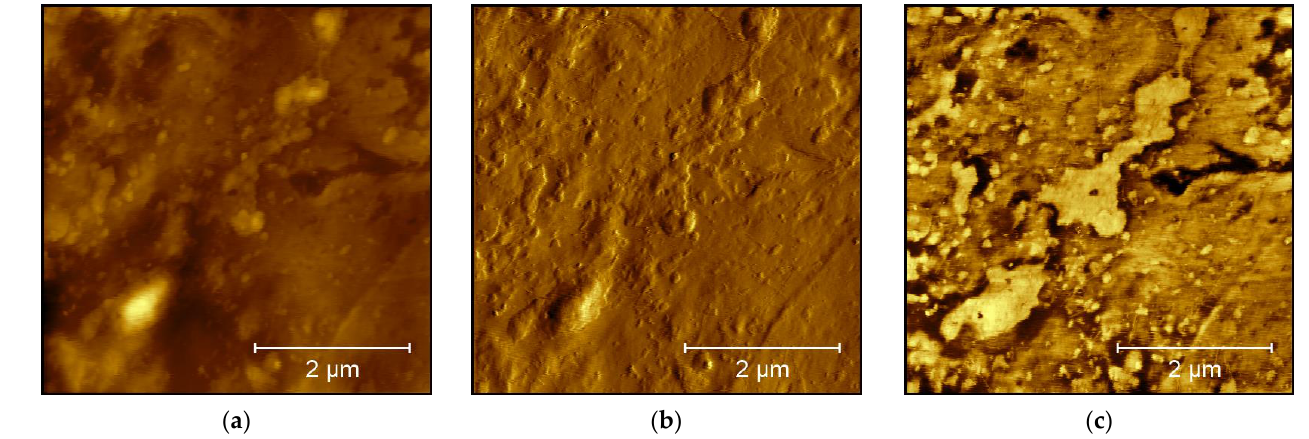
Figure 12. AFM images of a 3D printed TopZeal surface: ( a ) topography (height range 216 nm); ( b ) amplitude; ( c ) phase image (phase range 43°).